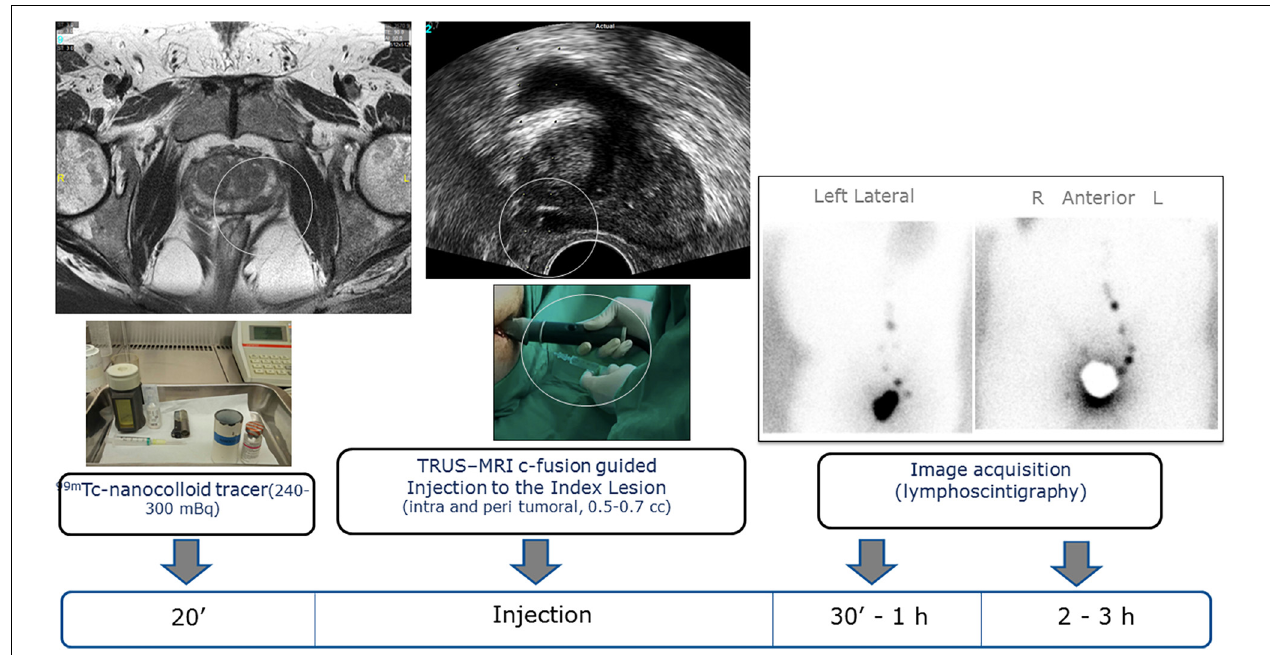
FIGURE 1 | Transrectal ultrasound injections of diluted 99 m Tc-nancolloid to the index lesion and peripheral area before surgery. Lymphoscintigraphy, 1st day: Transrectal guided injection (TRUS) injection of diluted 99 m Tc-nanocolloid to the index lesion and peripheral area. MRI T2 weighted images showing a left lobe lesion (PZ). TRUS intralesional in the left lobe lesion. Lymphoscintigraphy images showing a left drainage predominantly in obturator fossa and external iliac artery area.